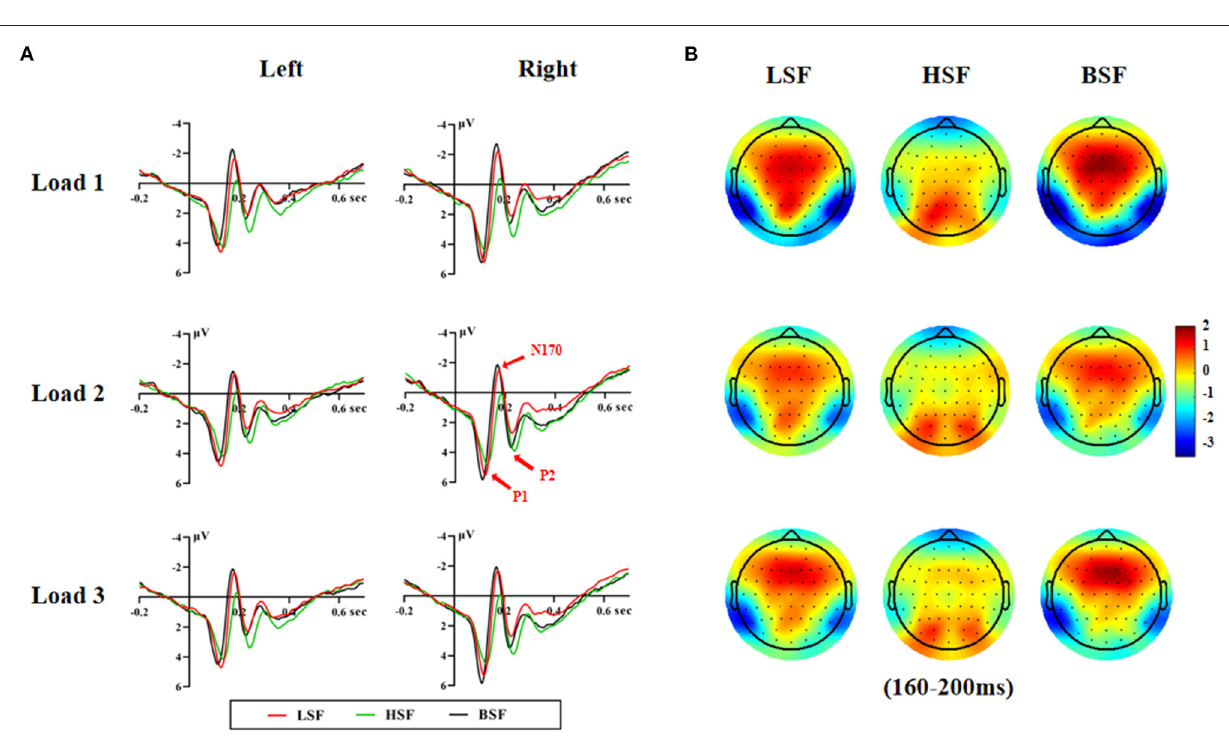
Frontiers in Psychology |